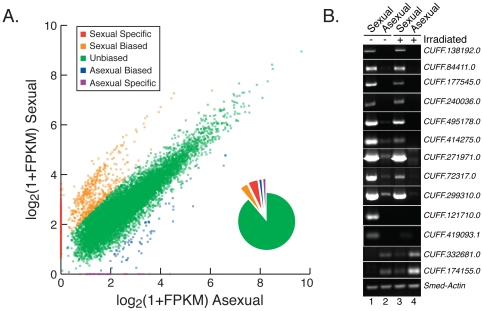
Strain-specific transcript expression.(A) Scatterplot of log2(1+FPKM) values for transcripts expressed in non-irradiated asexual (x-axis) and sexual (y-axis) animals. Biases in expression are categorized as follows: sexual-specific (red), sexual-biased (orange), unbiased (green), asexual-biased (blue) and asexual-specific (purple). The piechart (inset) shows the fraction of transcripts that fall into each category. (B) RT-PCR validation of strain-biased expression in sexual and asexual non-irradiated (−) and irradiated (+) samples; results are shown for 13 samples (Smed-actin used as a control).